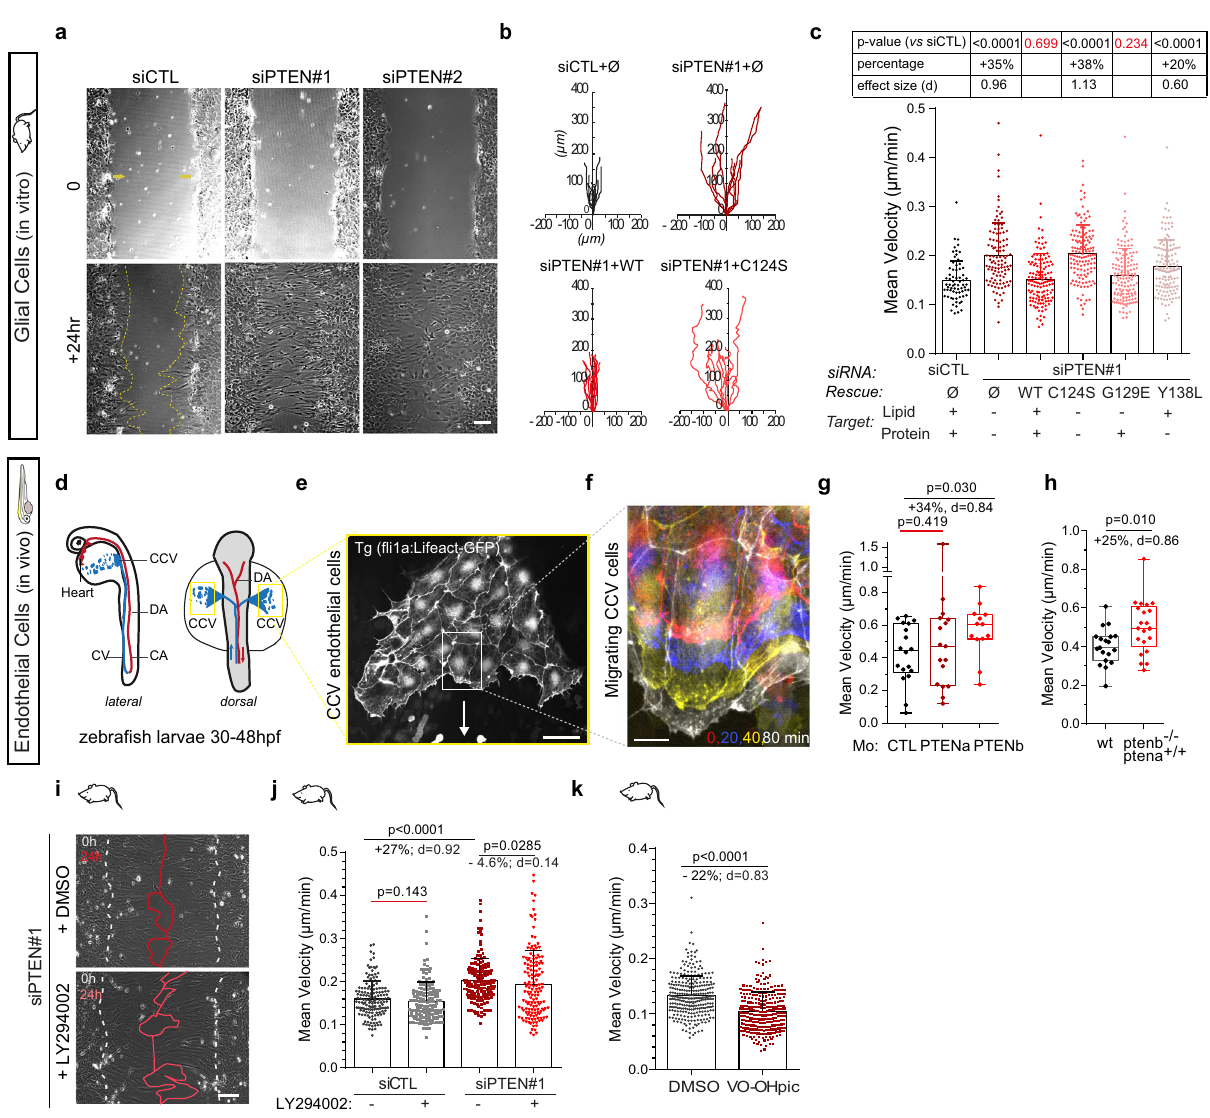
Fig. 1 PTEN loss enhances collective cell migration independently of PI3K/AKT signalling. a Phase-contrast images of siCTL and PTEN-depleted (siPTEN#1,2) astrocytes migrating collectively in a wound-healing assay. Scale bar: 100 μ m. b Diagrams showing 24 h-trajectories of 10 representative siCTL, and siPTEN#1 cells rescued with GFP alone (Ø), PTEN-WT(WT) and PTEN-C124S (C124S). c Mean astrocyte velocity. 69 siCTL cells, 107 siPTEN + Ø cells, 133 siPTEN + wt cells, 133 siPTEN + C124S cells, 145 siPTEN + G129E cells and 137 siPTEN + Y138L cells from three biologically independent experiments were examined. Statistics were drawn using two-tailed Mann – Whitney test. p values and effect sizes vs siCTL are given in the table above the graph. d Schemes representing lateral and dorsal view of a 24/30hpf zebra fi sh embryo with dorsal (DA) and caudal arteries (CA) in red and the caudal (CV) and common cardinal (CCV) veins. CCV endothelial cells (ECs) are delaminating from the midline, moving towards the heart (yellow box). e Representative fl uorescent image of migrating ECs expressing Lifeact-eGFP. Scale bar: 50 μ m. The micrograph is representative of at least 12 independent fi sh larvae. f Time-colored zoomed-in image of migrating ECs. Red is t = 0, blue is t = 20 min, yellow is t = 40 min and white is t = 180 min. Scale bar represents 10 µ m. g , h Mean velocity of lifeact-eGFP expressing ECs in control zebra fi sh embryos (MoCTL), ptena morphant (MoPTENa) and ptenb morphant (MoPTENb) ( g , n = 18, 17, 13 cells; N = 4 fi sh, two-tailed unpaired t -test) and in wild-type pten and in ptenb − / − mutant zebra fi sh embryos ( h , n = 19, 21 cells; N = 6, 5 fi sh; two-tailed unpaired t -test). i Phase-contrast images of siPTEN#1 cells treated with DMSO or the PI3K inhibitor LY294002. White dashed lines delineate the border of the wound at t = 0. Red lines delineate the border of the monolayer 24 h later. Scale bar 100 μ m. j , k Mean velocity of siCTL and siPTEN cells treated with or without LY294002 ( j , n = 198 cells, N = 3, two-tailed Mann – Whitney test) and with DMSO or VO-OHpic ( k , n = 300, N = 3, two-tailed Mann – Whitney). Error bars represent Standard Deviation (SD). Boxes for box-plot graphs ( g , h ) extend from the 25th to 75th percentiles and the line in the middle is plotted at the median. Whiskers delineate all data points from minimum to maximum. Source data are provided as a Source Data fi le. PTEN loss alters interjunctional actin arcs in leader cells . investigated the impact of PTEN depletion on the actin cytos- keleton and the cell-cell junctions. In the front row of migrating Collective cell migration relies on the synchronisation of astrocytes, F-actin form both longitudinal fi bres anchored at the pathways permitting cytoskeleton remodelling and the main- leading edge focal adhesions, and Interjunctional Transverse tenance of intercellular adhesion 32 – 34 . To unveil how PTEN loss leads to an increase in cell migration velocity, we Arcs (ITA) that are oriented perpendicularly to the direction of NATURE COMMUNICATIONS| (2022) 13:4528